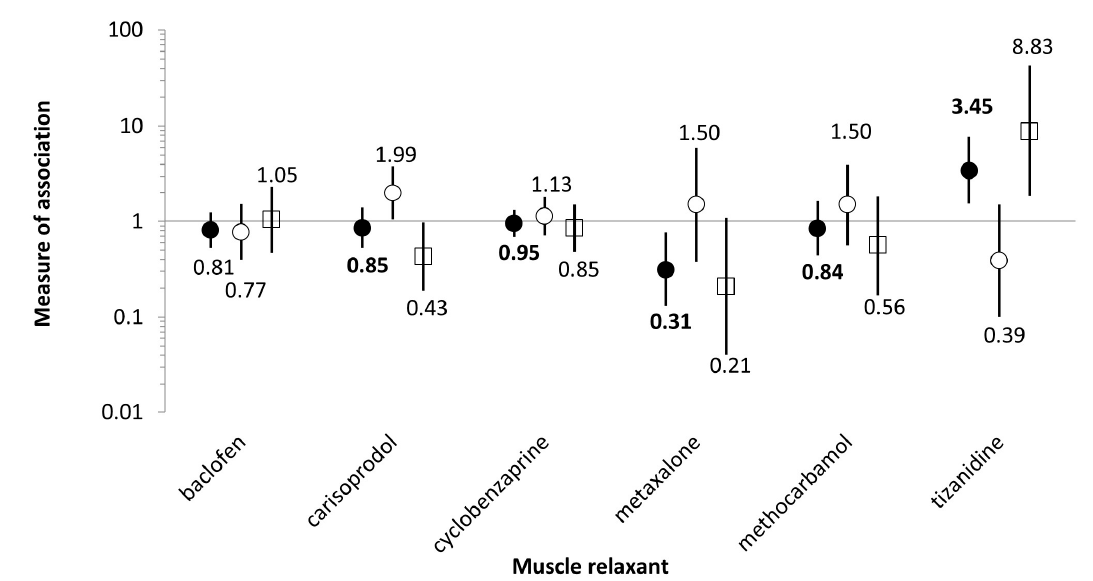
Figure 1. Confounder-adjusted incidence rate ratios (IRRs, circles) and ratios of adjusted incidence rate ratios (rIRRs, squares) with 95% confidence intervals for thromboembolism, for primary analyses, by muscle relaxant precipitant drug. Legend : Black circles: confounder-adjusted incidence rate ratios (IRRs) for warfarin (bolded since effect estimates of primary interest); White circles: confounder adjusted IRRs for inhaled corticosteroids (negative control); White squares: ratios of IRRs, i.e., ([adjusted incidence rate ratios for use of warfarin + muscle relaxant vs. warfarin alone]/[adjusted incidence rate ratios for use of inhaled corticosteroid + muscle relaxant vs. inhaled corticosteroid alone]).